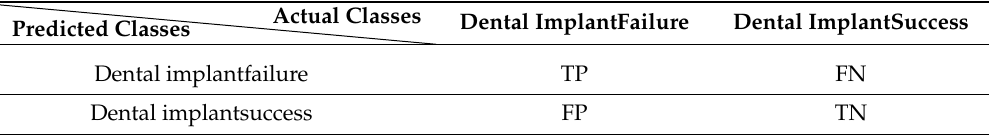
Table 2. Confusion